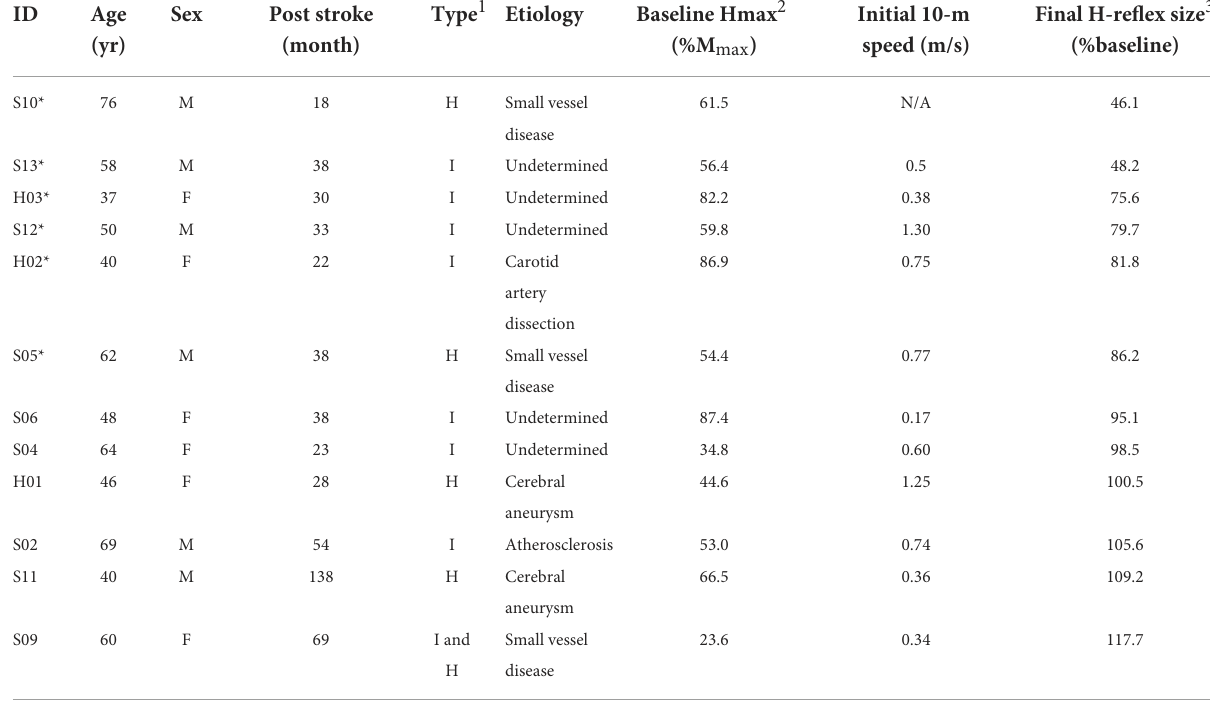
TABLE 1 Clinical demographics of study